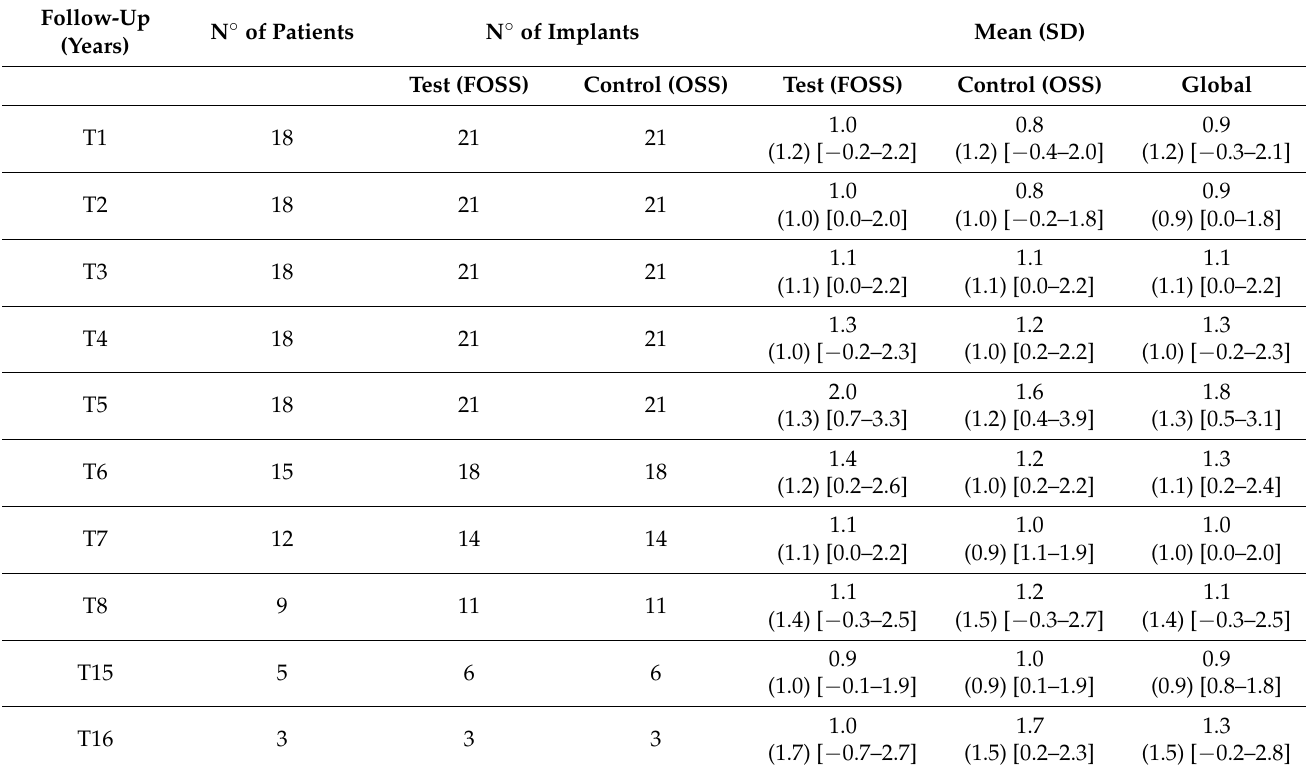
Table 4. Values of BOP over time for OSS and FOSS implants.